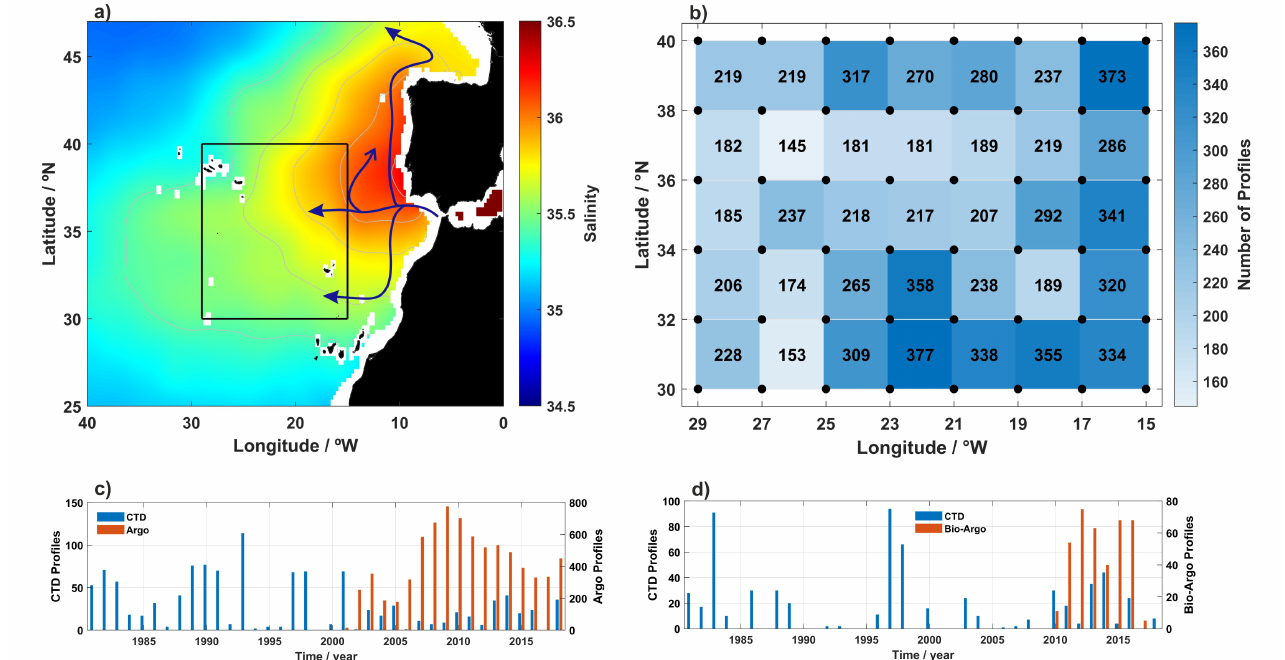
Figure 1. ( a ) Climatological distribution of the salinity at 1000m from the World Ocean Atlas (WOA18) [33]. Dark blue lines are a schematic representation of the main pathways of the Mediterranean Outflow Water after exiting the Strait of Gibraltar in the eastern part of the subtropical gyre (adapted from [12,15,34]). The black box delimits the study area. ( b ) Number of temperature and salinity profiles for each box of the 2 ◦ × 2 ◦ grid over the study domain in ( a ). Temporal distribution of temperature and salinity profiles obtained with CTD and Argo floats ( c ) and oxygen profiles acquired by CTD and Bio-Argo floats ( d ) for each